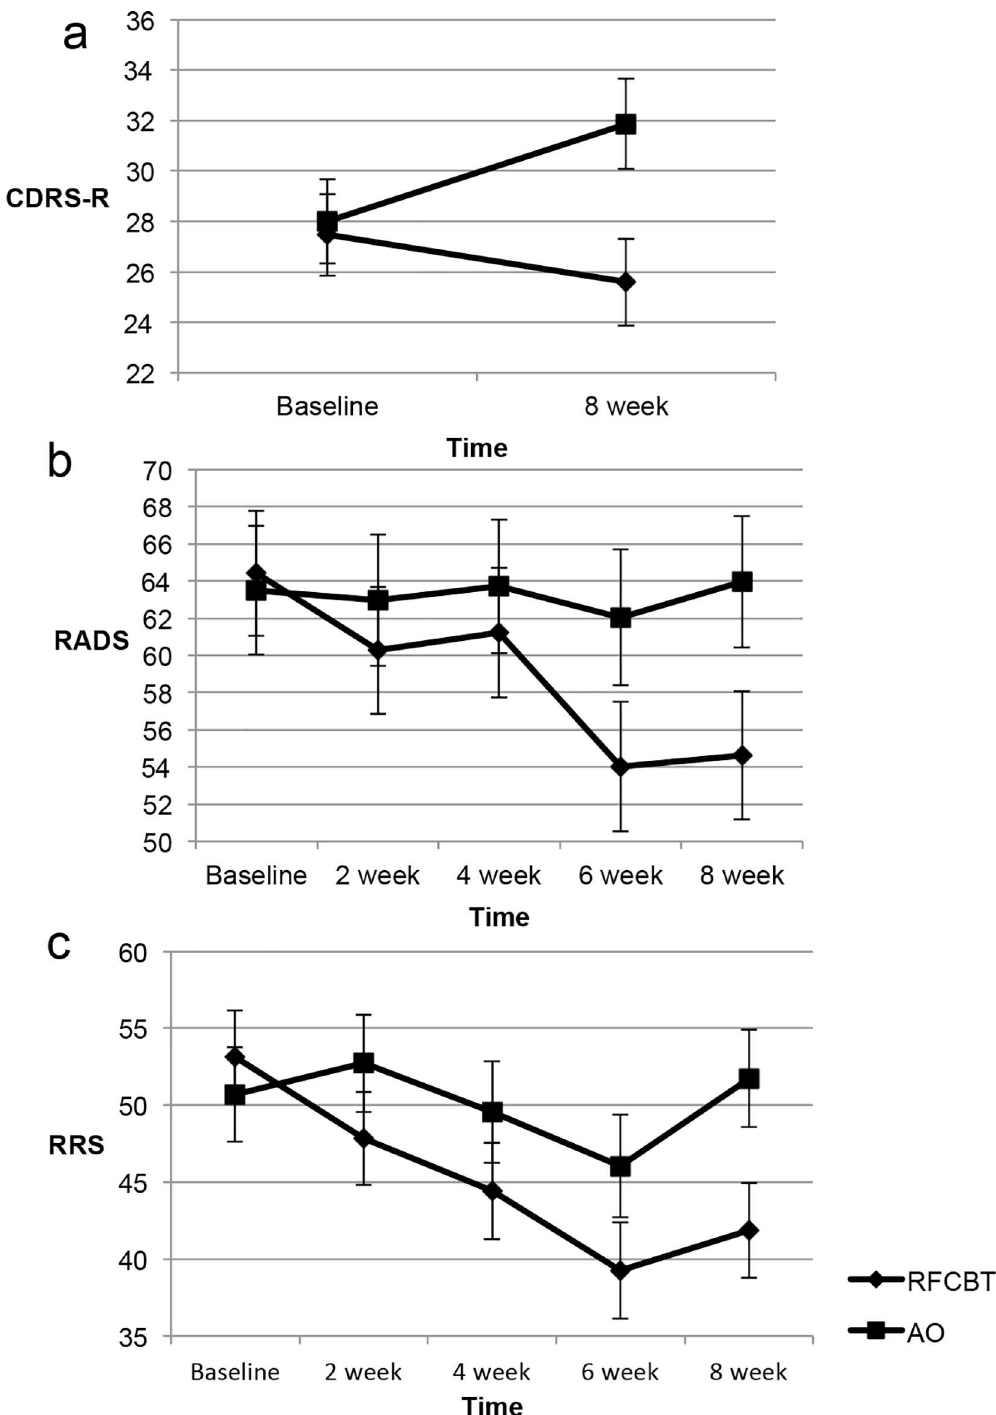
Fig 2. Changes in and depression and rumination over eight weeks among remitted adolescents. Predicted means and standarderrors deriving from MRMs. RFCBT = Rumination-focusedCognitive BehaviorTherapy, AO = Assessment Only, RRS = Ruminative Responses Scale, CDRS-R = Children’s DepressionRating Scale– Revised,RADS = ReynoldsAdolescentDepression Scale. Panel a illustrates change in CDRS-R, panel b illustrates changein RADS, panel c illustrateschange in